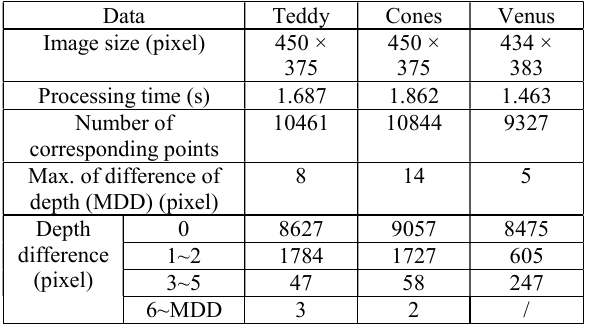
Table 4. Statistical results of processing time and depth difference of the natural scene